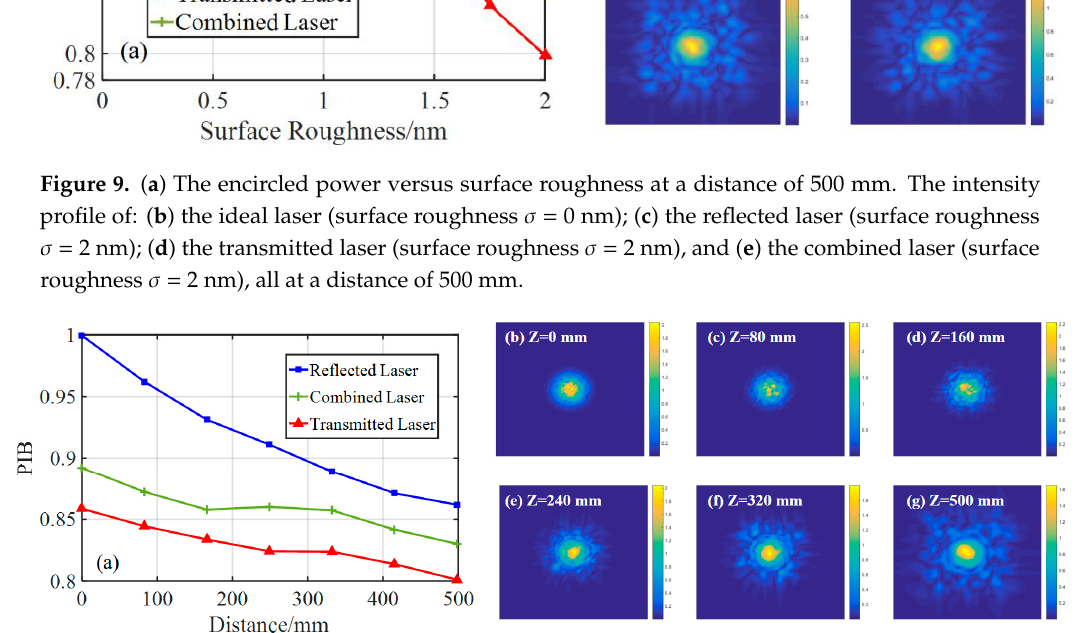
Figure 9. ( a ) The encircled power versus surface roughness at a distance of 500 mm. The intensity profile of: ( b ) the ideal laser (surface roughness σ = 0 nm); ( c ) the reflected laser (surface roughness σ = 2 nm); ( d ) the transmitted laser (surface roughness σ = 2 nm), and ( e ) the combined laser (surface roughness σ = 2 nm), all at a distance of 500 mm.